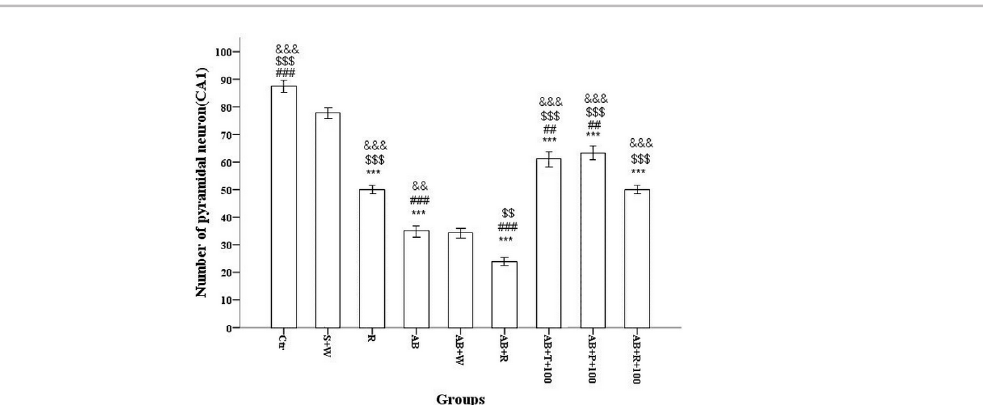
FIGURE 4 - Neuron numbers in different groups Comparison of control group (Ctr) with other groups (*** p<0.001); comparison of restraint (R) group with other groups (### p<0.001); comparison of AD group (AB) with others ($$$ p<0.001); comparison of AD and restraint stress group (AB +R) with other groups ( &&& p<0.001). Please refer to the Methods and Materials section